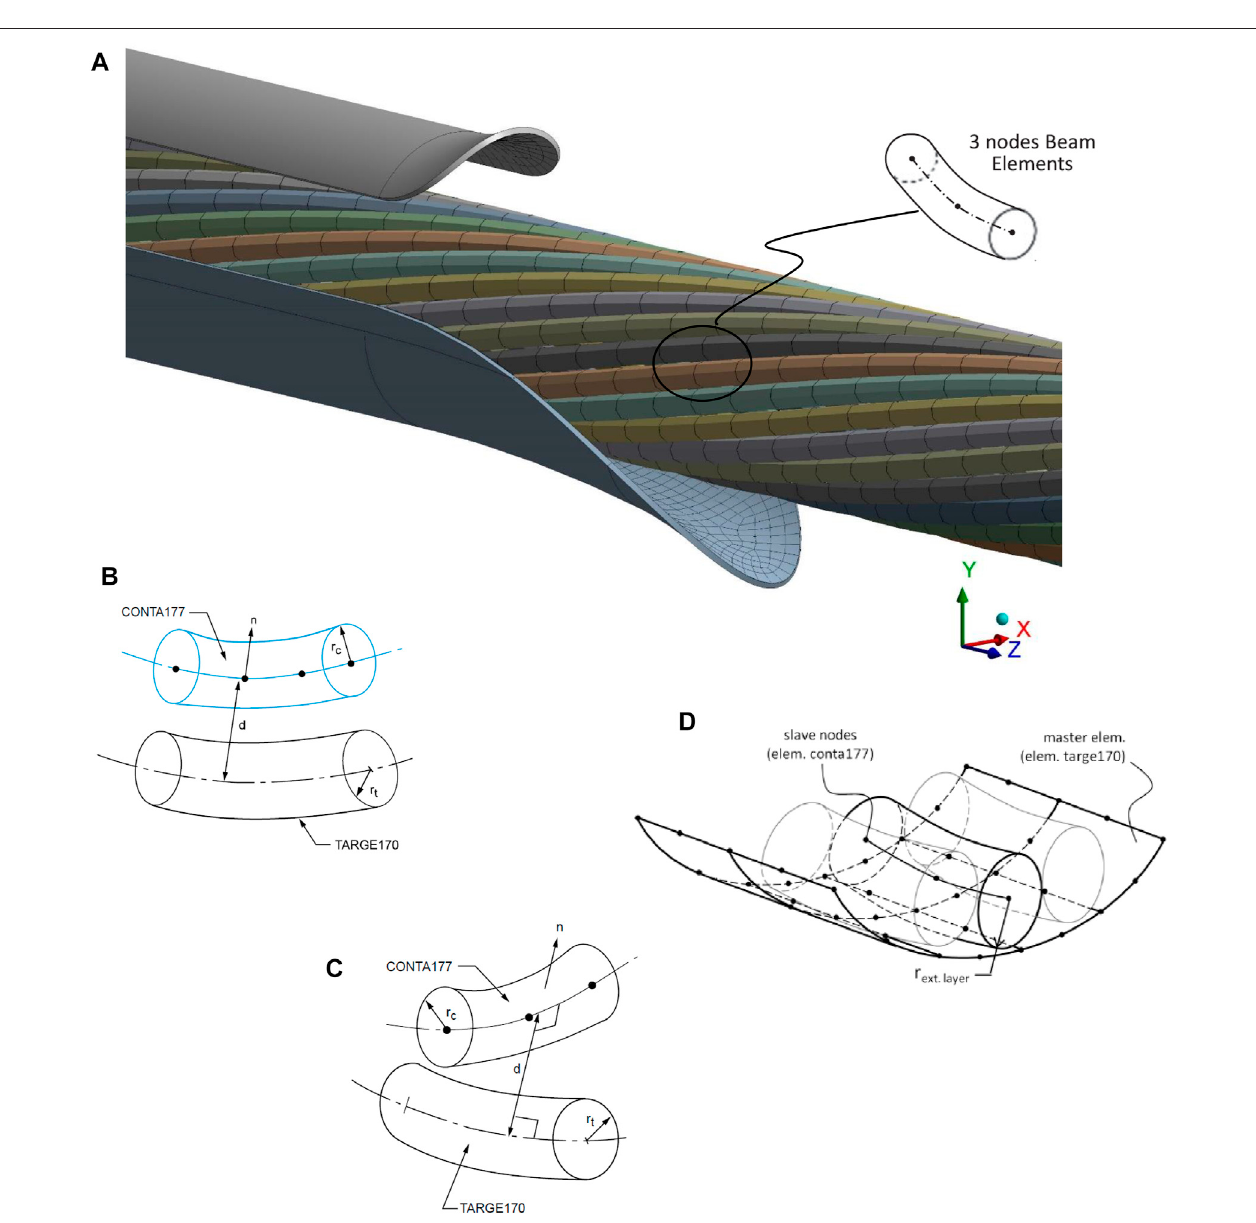
FIGURE 4 | (A) Finite element mesh of the Bersfort conductor-clamp assembly showing the beam and rigid shell elements. (B) Line-to-line contact between the conductor wires of the same layers modeled with slave element CONTA177 and master element TARGE170. (C) Line-to-line contact between the conductor wires of different layers modeled with slave element CONTA177 and master element TARGE170. (D) Line-to-surface contact between the layer 4 wires and the keeper/clamp.